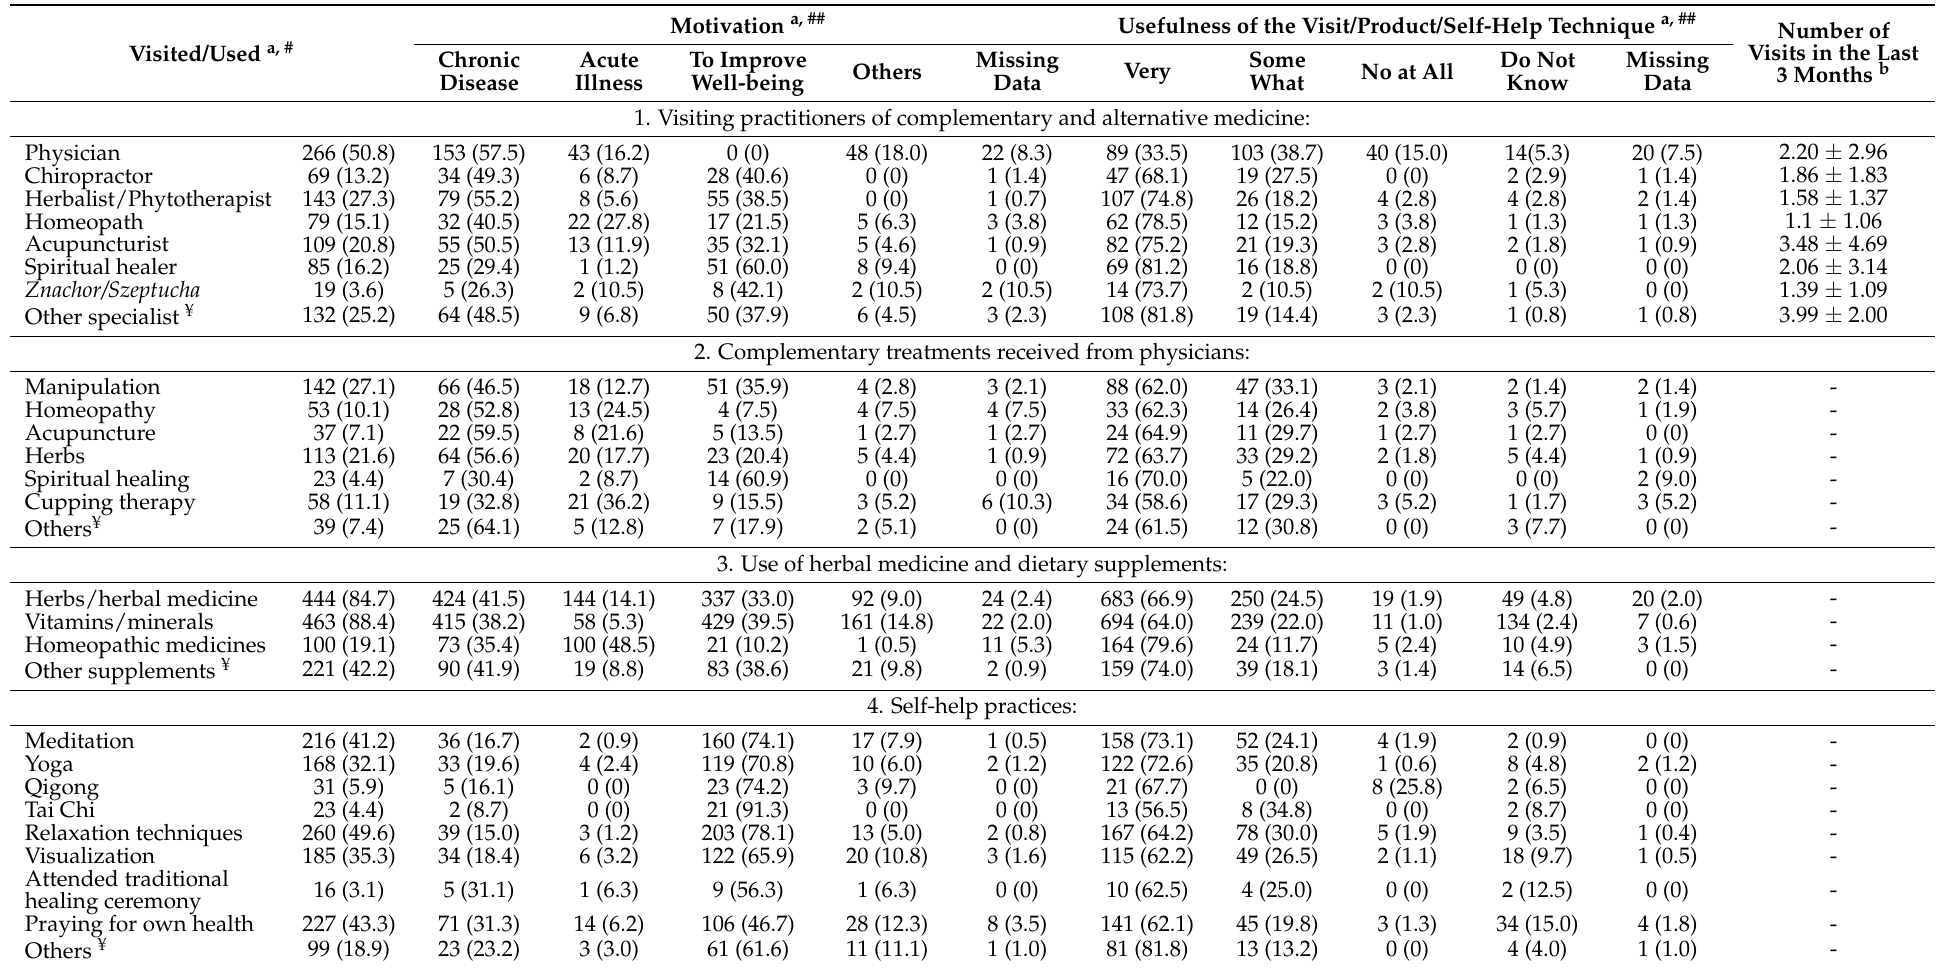
Table 2. The frequency, motivation and evaluation of CAM use in the study group during the last 12